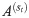
Hidden Markov model as a graphical model.Upper row depicts the evolution of states st according to the transition matrix A(st). The states emit observational data (dotted rectangle) according to the probabilities specified in stochastic matrix B(st) which depends on the type of inference. The stimulus probability model infers the emission probabilities associated with the raw observations ot. The alternation probability model tracks the alternations of observations with dt=1ot≠ot−1. The transition probability model assumes a data-generating process based on previous observations, with et coding for the transitions between observations.